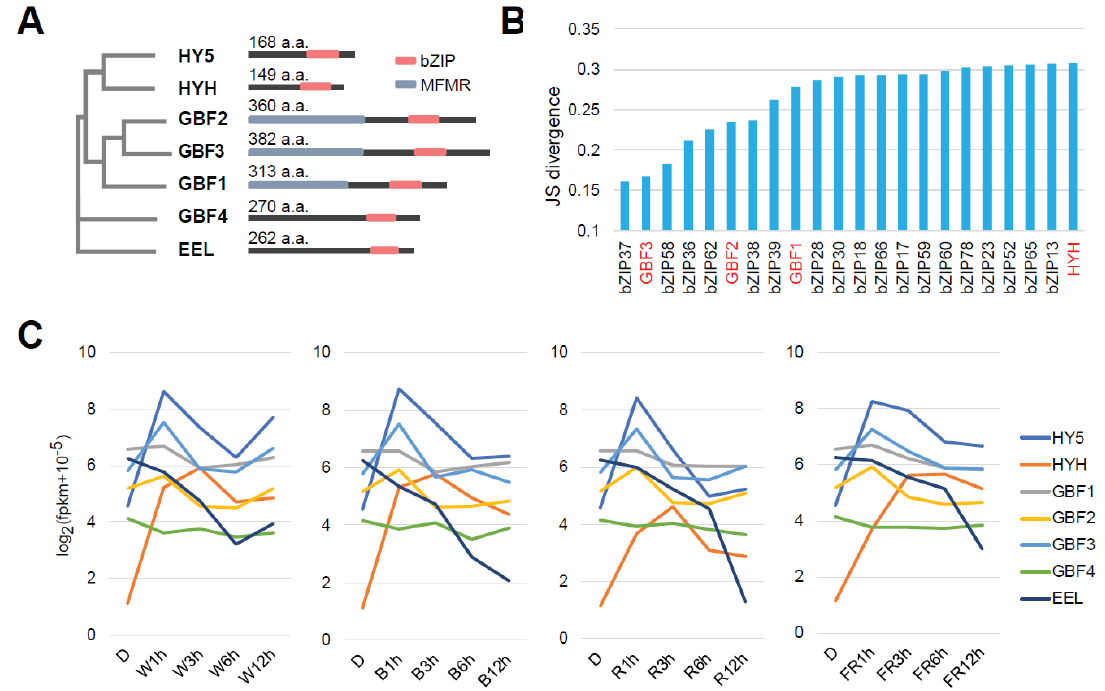
Figure 4. Expression profiles of bZIP transcription factor (TF) genes upon light exposure. (A) Phylogenetic tree and domain structures of HY5 and the other bZIP TFs. MFMR = MultiFunctional Mosaic Region. (B) Jensen-Shannon (JS) divergence of bZIP TF genes for co-expression with HY5 on exposure to light. (C) Expression of seven bZIP genes, HY5 , HYH , GBF1 , GBF2 , GBF3 and EEL , in each type of light.